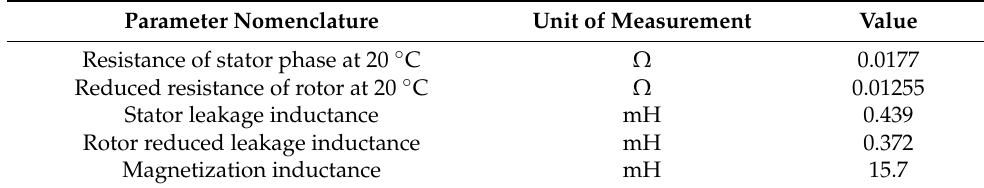
Table 5. Parameters of the equivalent circuit of asynchronous electric